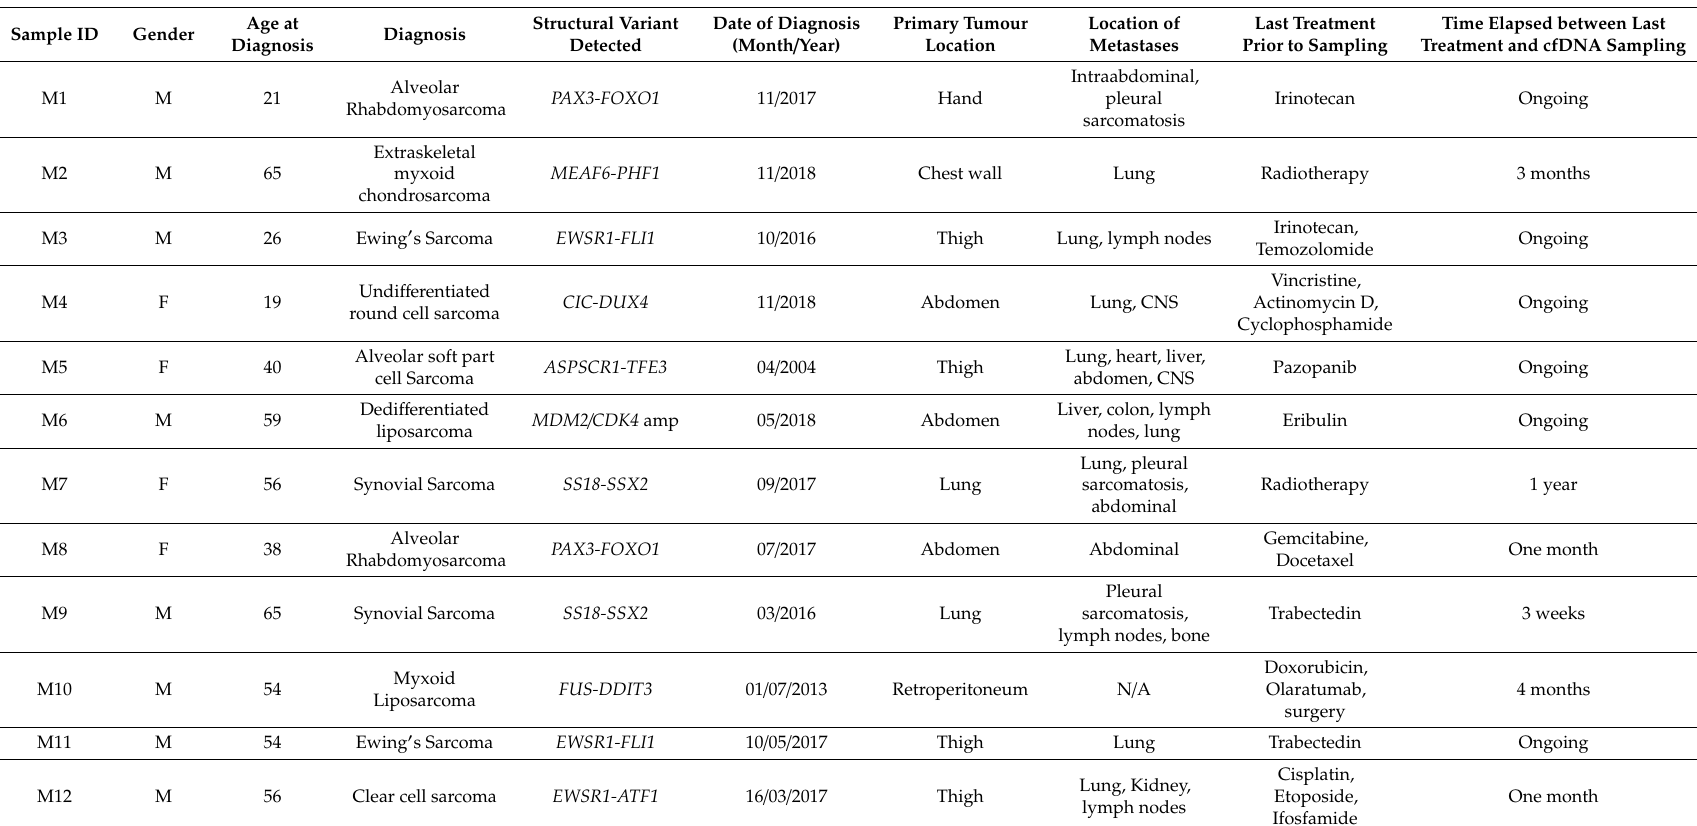
Table 2. Clinical information for